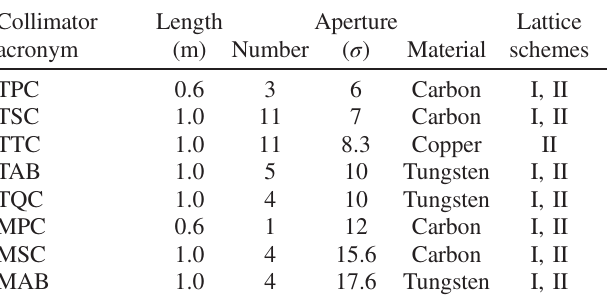
TABLE III. Collimator parameters for the SPPC.